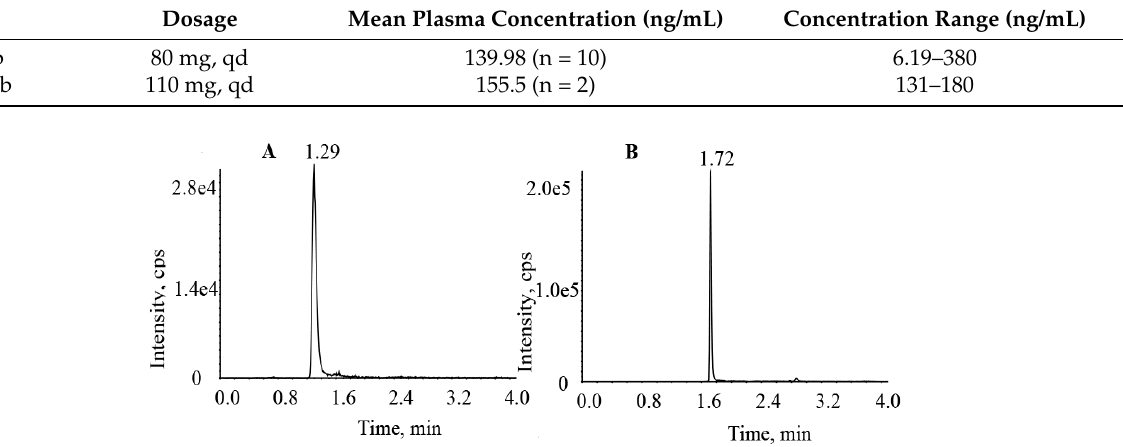
Figure 4. Chromatogram of plasma samples from patients treated with ( A ) osimertinib and ( B ) aumolertinib.